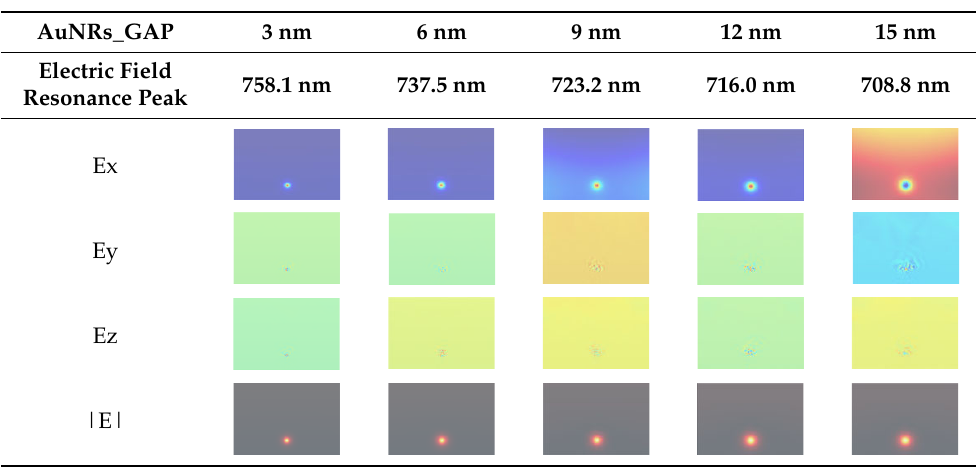
Table 4. Electric field distribution under the resonance peak of the gold nanorod dimer in the longitudinal structure (Y-Z section).